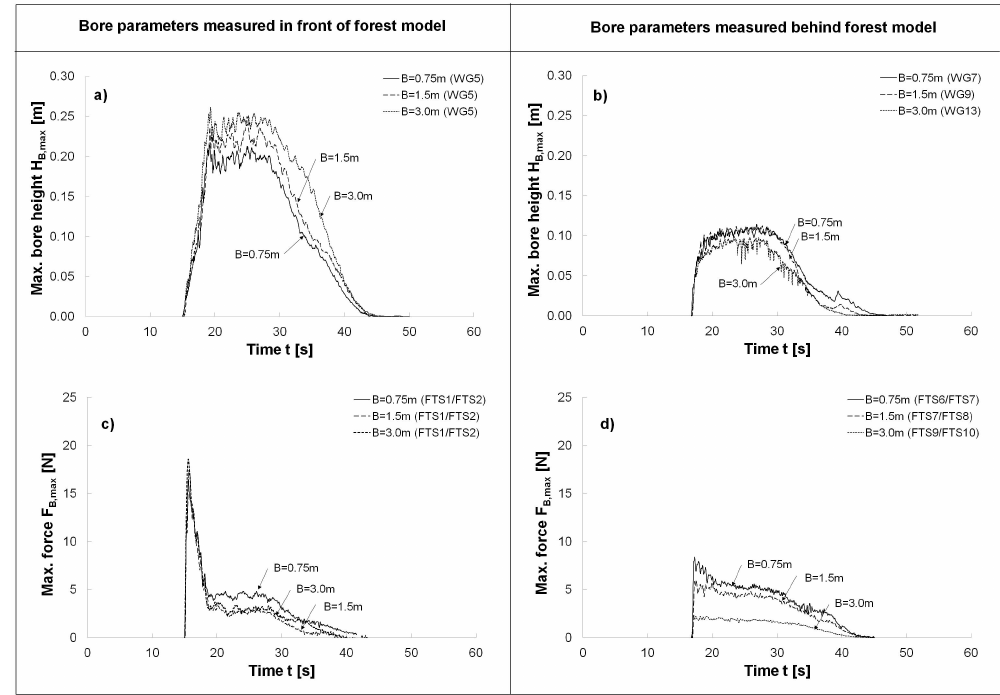
Fig. 14. Selected time histories of bore parameters (water depth behind bore gate h o = 0.8m, water depth in front of bore gate h 1 = 0.3m): (a, b) bore height in front of and behind forest model, respectively; (c, d) bore-induced forces exerted on single tree models in front of and behind forest model, respectively (see also Fig. 5b for wave gauge locations; Fig. 6 and Table 1 for force transducer